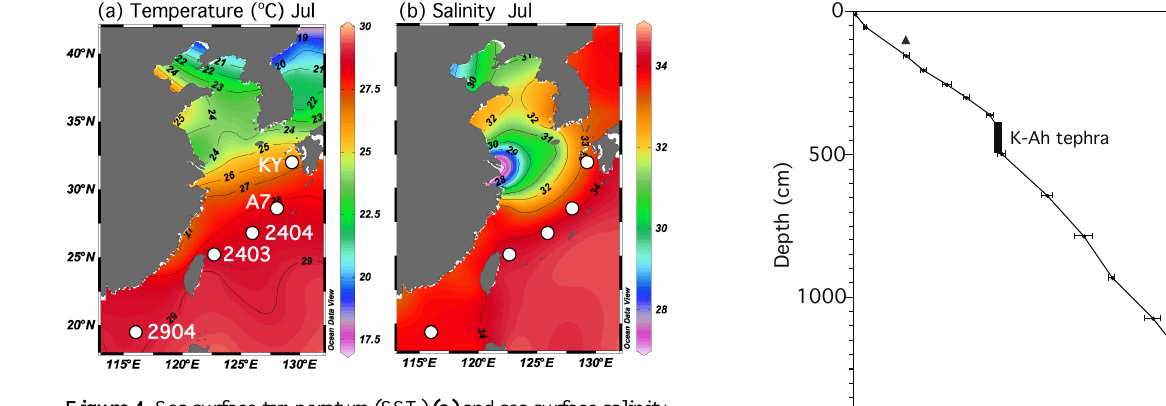
Figure 4. Sea surface temperature (SST) (a) and sea surface salinity (SSS) and (b) in July in the ECS (Locarnini et al., 2010; Antonov et al., 2010) and core locations described in the text. Maps made with Ocean Data View (Schlitzer, 2014).